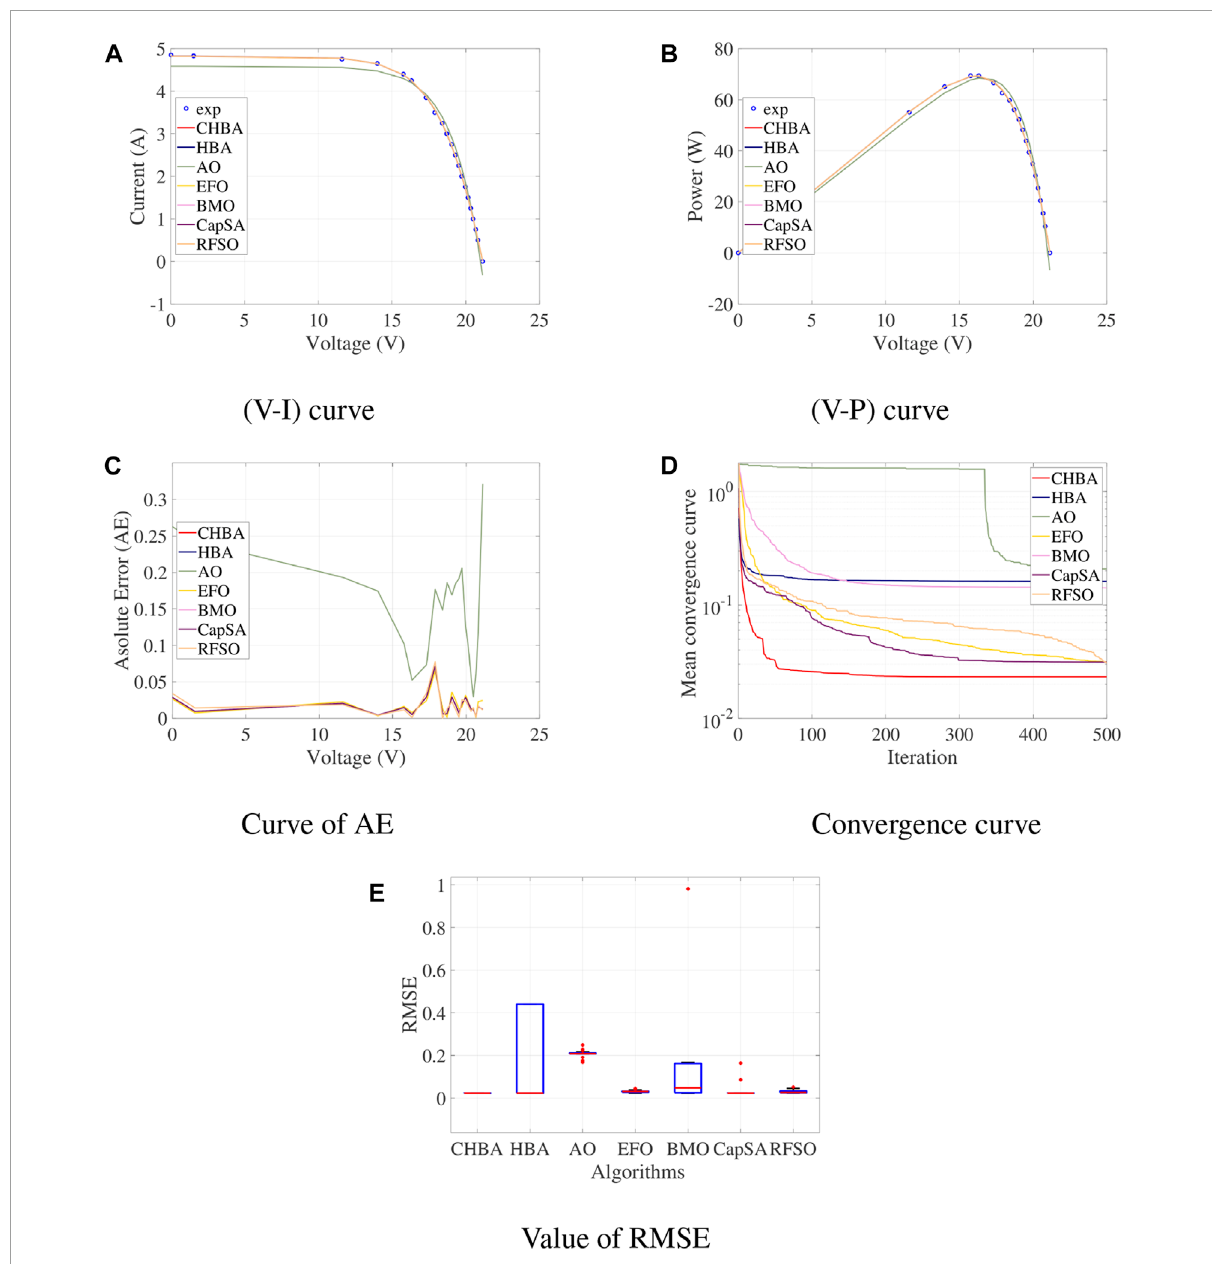
FIGURE 8 Behaviour of competitive techniques using DDM of SLP080 solar